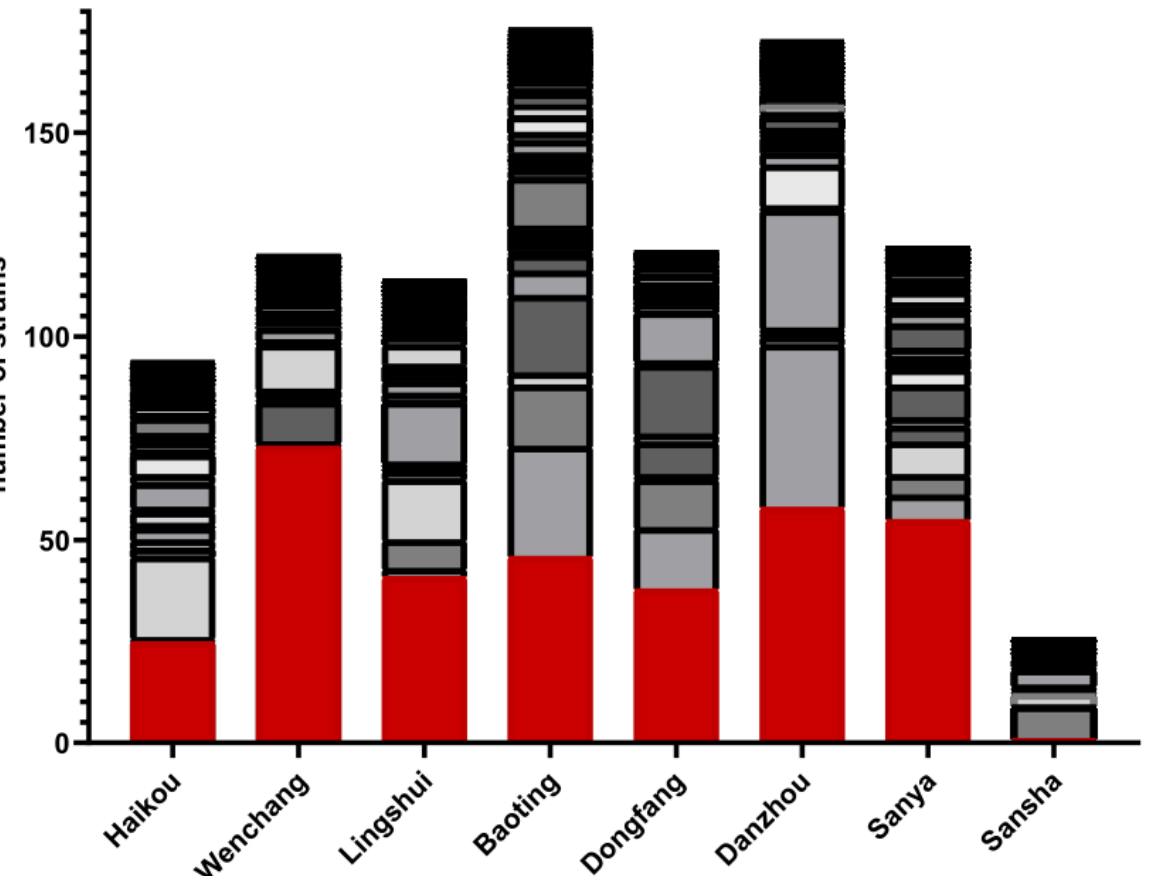
Figure 5. Prevalence of opportunistic yeast pathogens in environmental samples from eight mu- nicipalities in Hainan province in tropical China. Highlighted in red are the number of strains of pathogenic yeast species, and those in various shades of gray are not known to be pathogenic to humans.